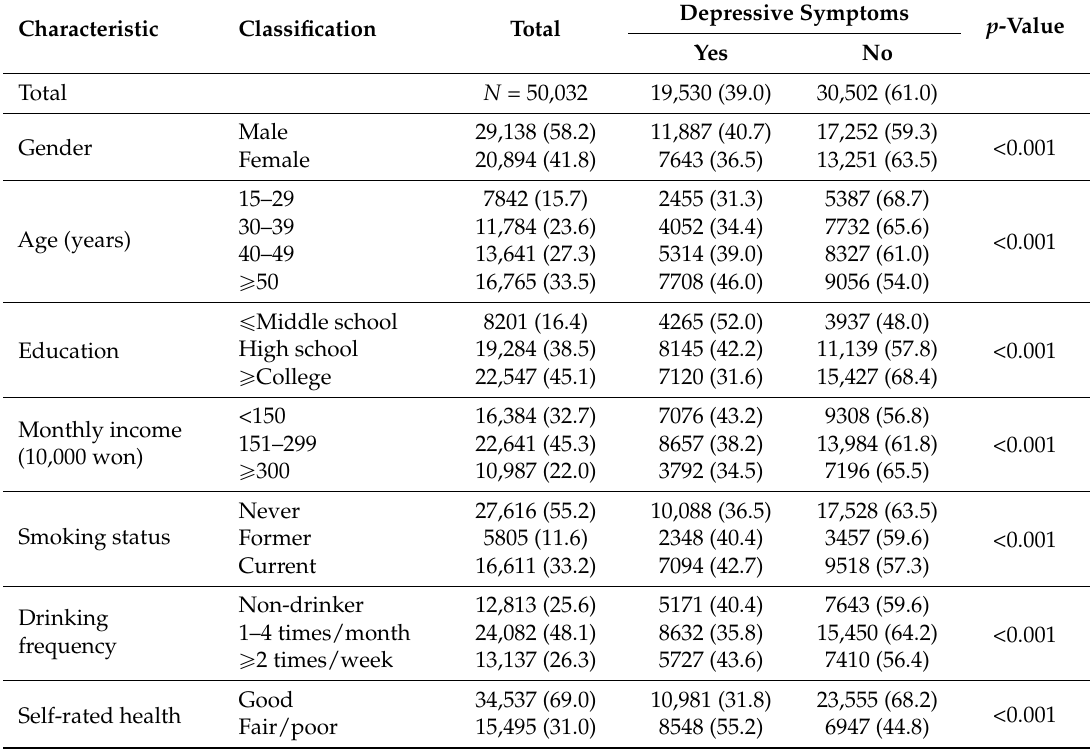
Table 1. Association between depressive symptoms and general characteristics.